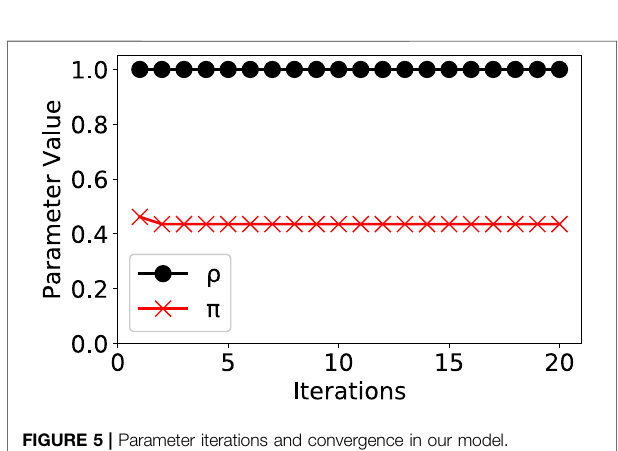
FIGURE 6 | Computational performance of out model on varying test region